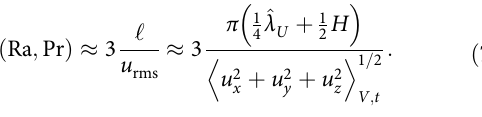
^ λ 2 π = k with k c = 3.117 at the onset of convection 23 . e c ¼ c = Ra = 1708. Characteristic wavelengths are c